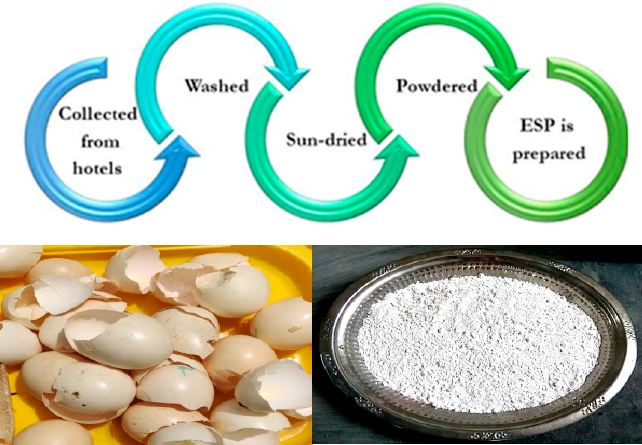
Figure 1. Method of eggshell powder manufacturing.